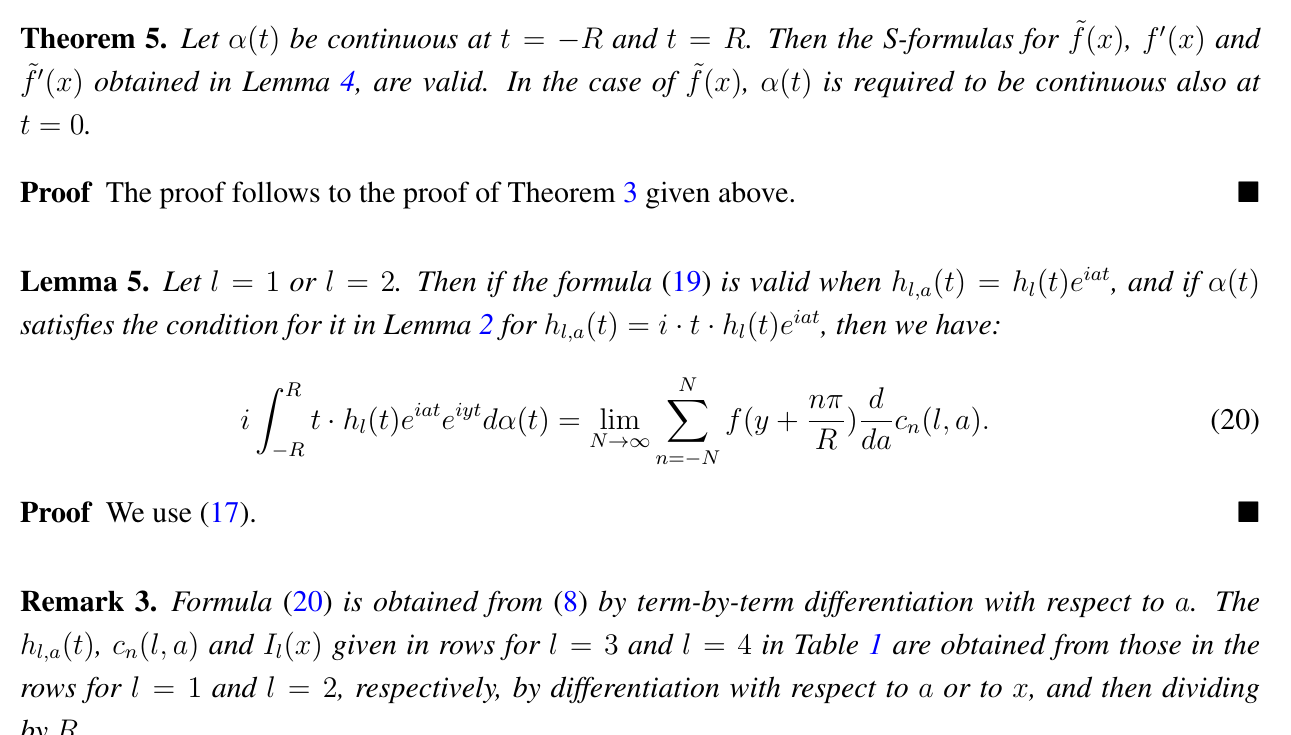
( l, a ) of function h n